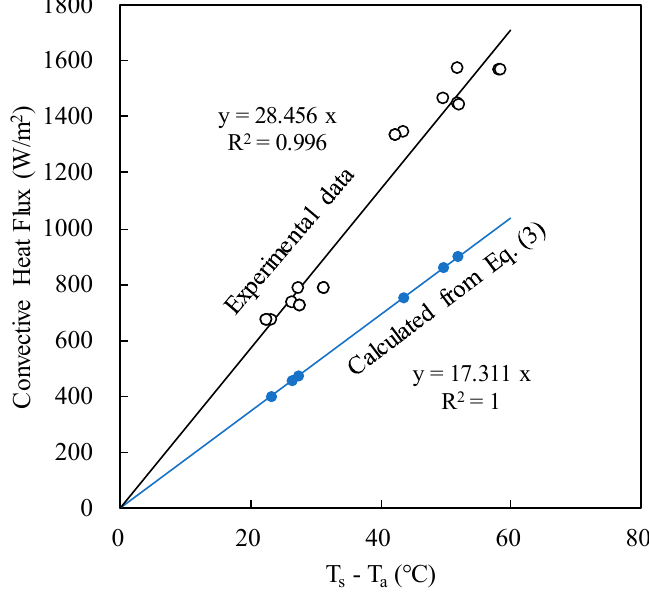
Figure 5. The linear correlation between convective heat flux and temperature difference.